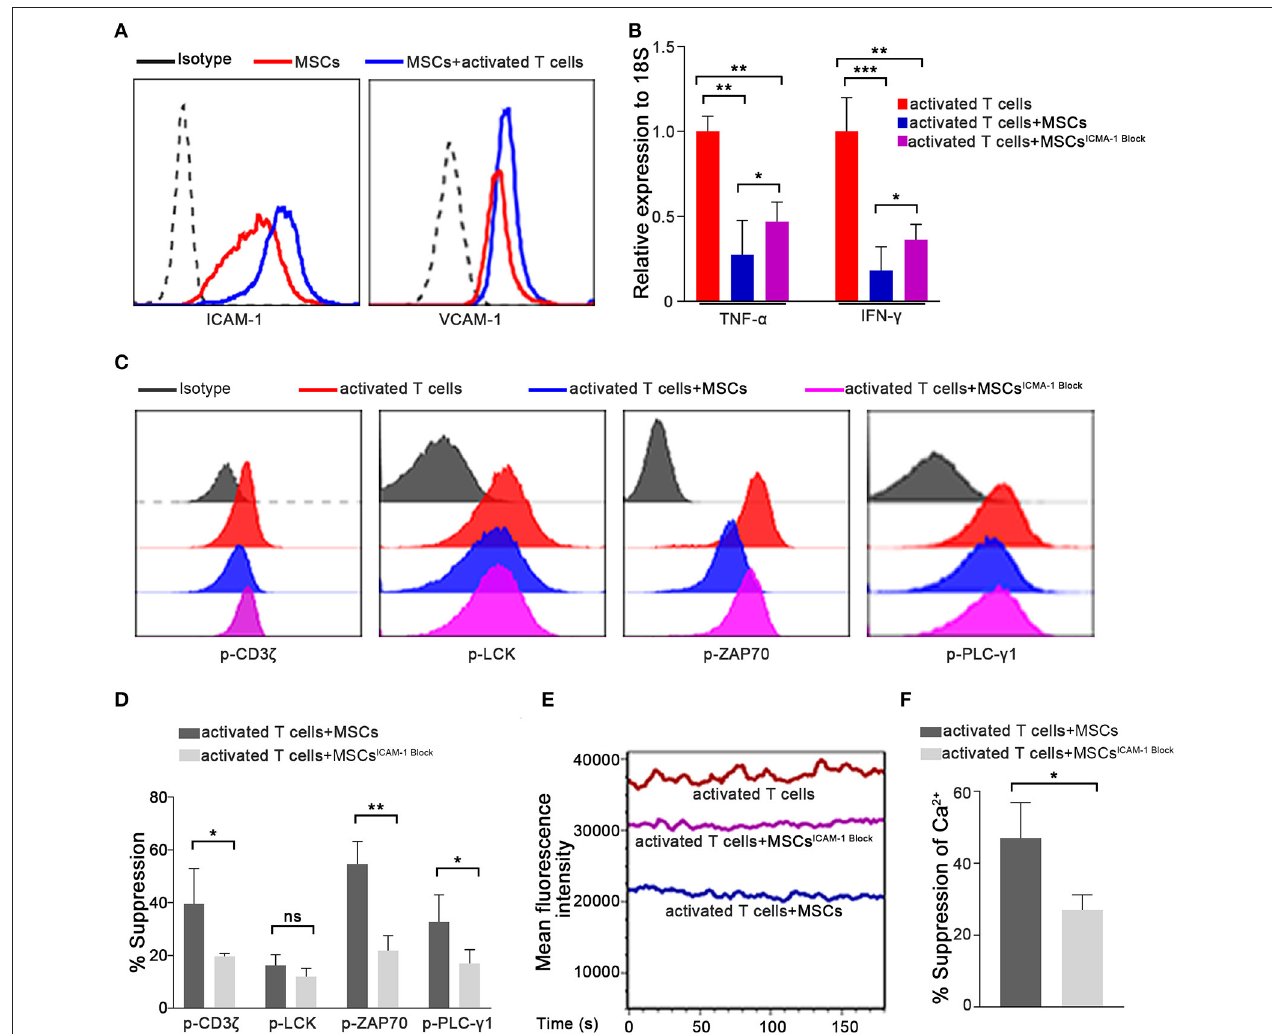
FIGURE 4 | The ability of MSCs to rapidly suppress activated T cell cytokine transcription is dependent on ICAM1-mediated cell-to-cell contact. (A) Expressions of ICAM-1 and VCAM-1 on the membranes of MSCs determined by flow cytometry are shown. All experiments were repeated at least three times using the sixth passage MSCs. (B) The mRNAs abundances of TNF- α and IFN- γ in activated T cells. Data are shown for activated T cells, activated T cells cocultured with MSCs, and activated T cells cocultured with ICAM-1-blocked MSCs. (C) Phosphorylation levels of CD3 ζ , LCK, ZAP70, and PLC- γ 1 in activated T cells from the three groups described above were examined by flow cytometry. The results presented are representative of those obtained from three independent experiments. (D) Bar graphs show the suppression percentages of p-CD3 ζ , p-LCK, p-ZAP70, and p-PLC- γ 1. Data are shown for activated T cells cocultured with MSCs and activated T cells cocultured with ICAM-1-blocked MSCs. All experiments were repeated three times. (E) Cytosolic Ca 2 + levels were tested by flow cytometry. The mean fluorescence intensity (MFI) is shown. The experimental groups are the same as described in (B) . (F) Suppression percentages of the Ca 2 + level in activated T cells from the coculture groups. The results are representative of three independent experiments. Data are presented as the mean ± SEM for each group. Significant differences are indicated as follows: ns, no statistical significance; * p < 0.05, ** p < 0.01, and *** p <